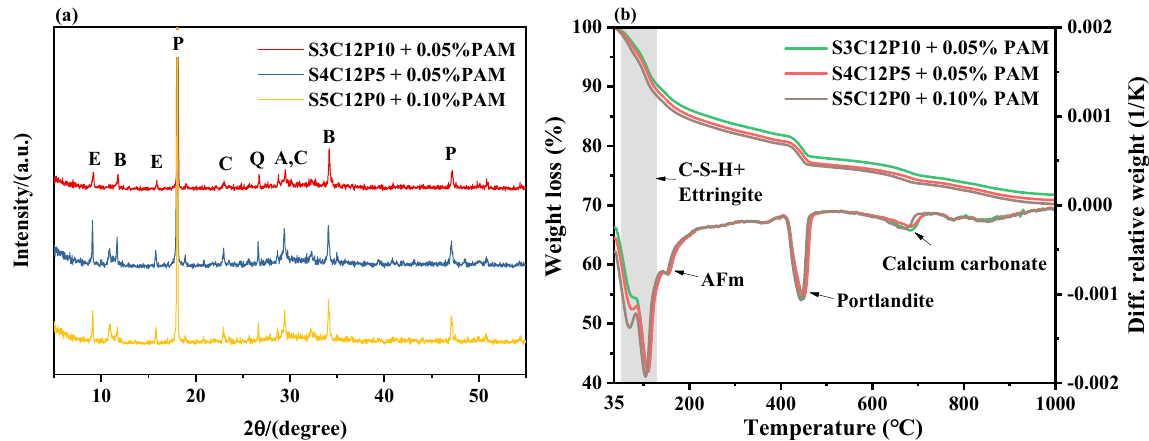
Figure 7. XRD patterns ( a ) and TG − DTG curves ( b ) of hydrated CPB specimens at 28 d (E—ettringite;